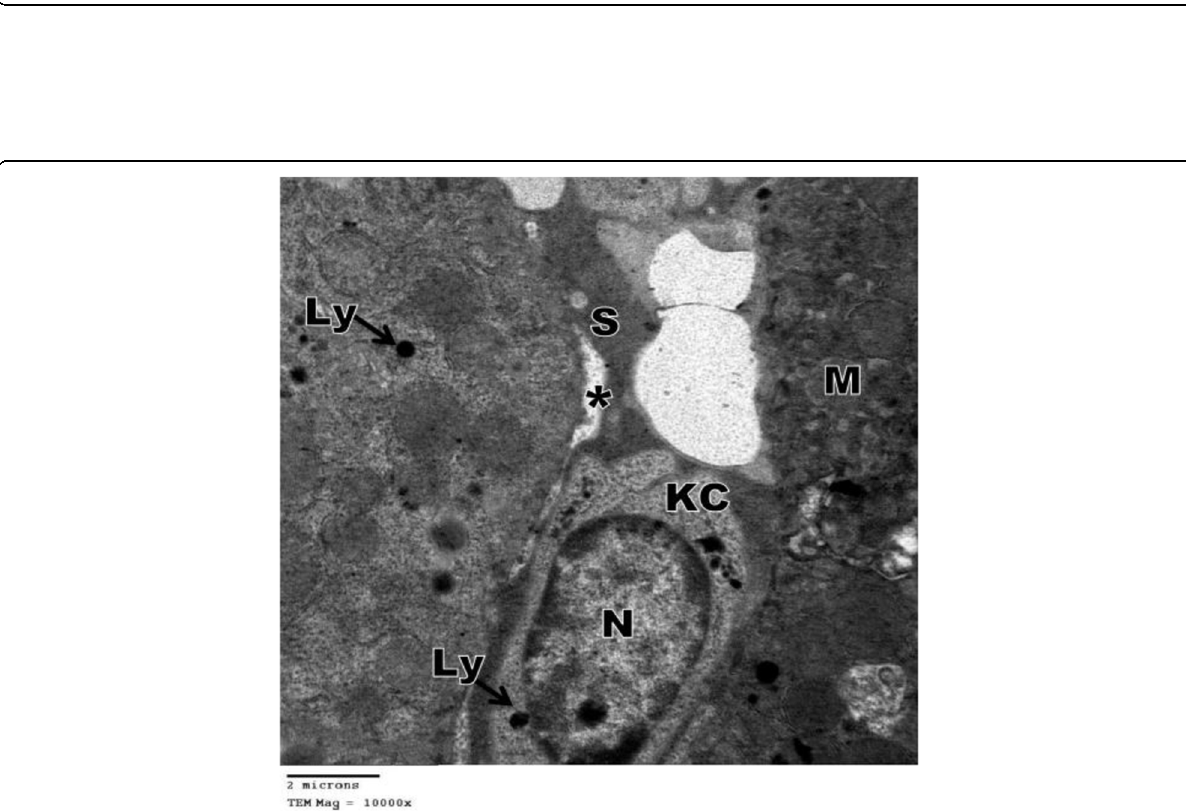
Fig. 29 An electron micrograph of a hepatocyte of the liver of treated mouse with Tamiflu (16 mg/kg b.wt.) in addition to Adamine (20 mg/kg b.wt.) for 10 days revealing lysosomes (Ly), swollen mitochondria (M) in hepatocyte, and sinusoid (S) had Kupffer cell (KC) containing lysosomes (Ly) and nucleus (N) in addition to space of Diss (*). (× 10,000)